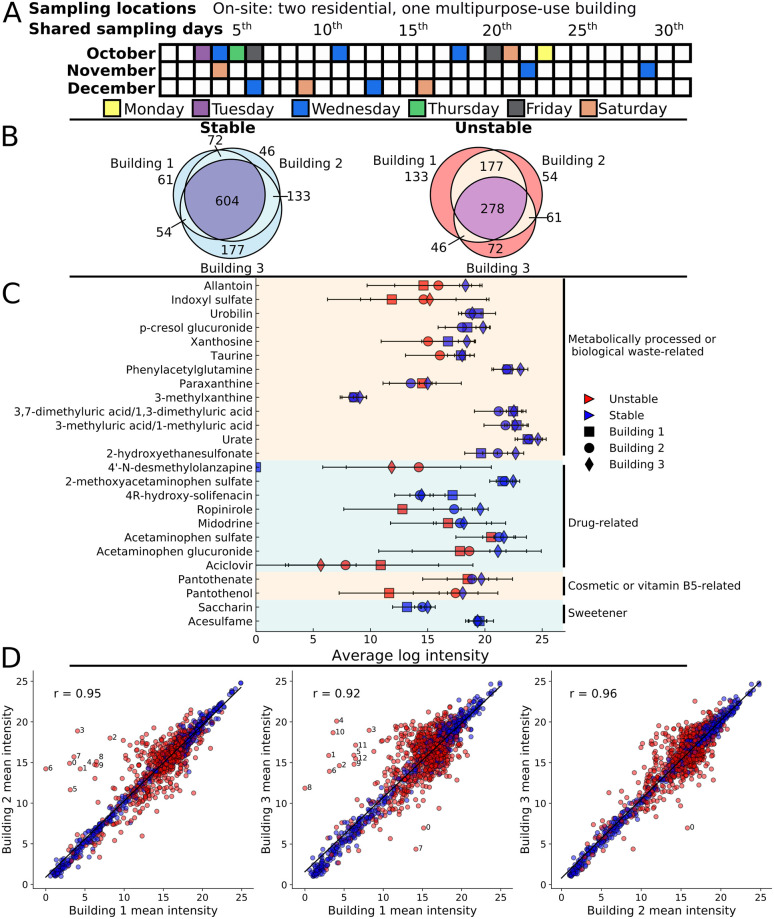
Multi-month sampling reveals numerous temporally stable and unstable features that generally possess comparable mean intensities across buildings.(A) Sampling timeline across three months for all buildings with shared sampling days filled with color. (B) Breakdown of the stable (through-time standard deviations < 2) and unstable metabolites and their overlap across the three buildings. (C) Average through-time mean log intensities and standard deviations of select features that were mapped to putative metabolites (level 2 identification); panel displays a selection of metabolites related to human activity, drugs, vitamin B5, and sweeteners. (D) Average through-time mean log intensity comparisons between all combinations of the three buildings. Red dots represent unstable features; blue dots represent features stable in at least one building. Building 1–2–0: N-decanoylglycine, 1: 237.9310Da/209.2619s, 2: girgensonine, 3: N-lauroylglycine, 4: 257.1955Da/491.0883s, 5: rhombifoline, 6: 4’-N-desmethylolanzapine, 7: 320.1906Da/475.7729, 8: 6-keto-decanoylcarnitine, 9: 445.0431Da/48.8418s; Building 1–3–0: 226.8621Da/33.2461s, 1: N-decanoylglycine, 2: 237.9310Da/209.2619s, 3: girgensonine, 4: N-lauroylglycine, 5: 257.1955Da/491.0883s, 6: rhombifoline, 7: acetylsulfamethoxazole, 8: 4’-N-desmethylolanzapine, 9: 1-[(3-chlorophenyl)methyl]-N,N-diethyl-3-piperidinecarboxamide^, 10: 320.1906Da/475.7729, 11: 6-keto-decanoylcarnitine, 12: 445.0431Da/48.8418s; Building 2–3–0: 226.8621Da/33.2461s. ^MS identity level 3, otherwise 2 for named compounds.